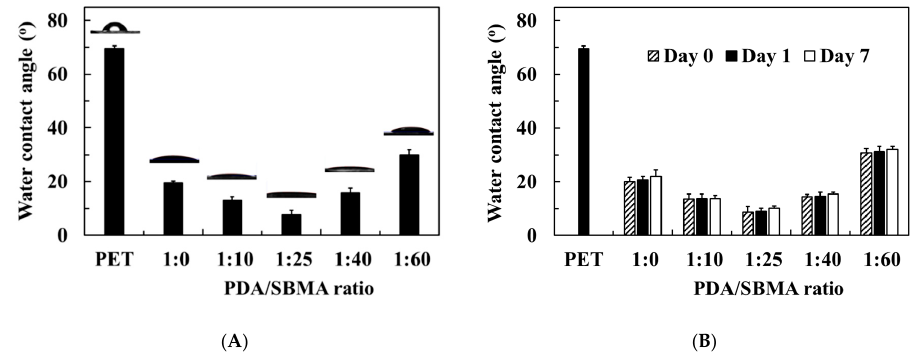
Figure 5. ( A ) Static WCAs of the various PDA/SBMA coatings. ( B ) Surface wettability of the coating for long-term immersion in PBS.